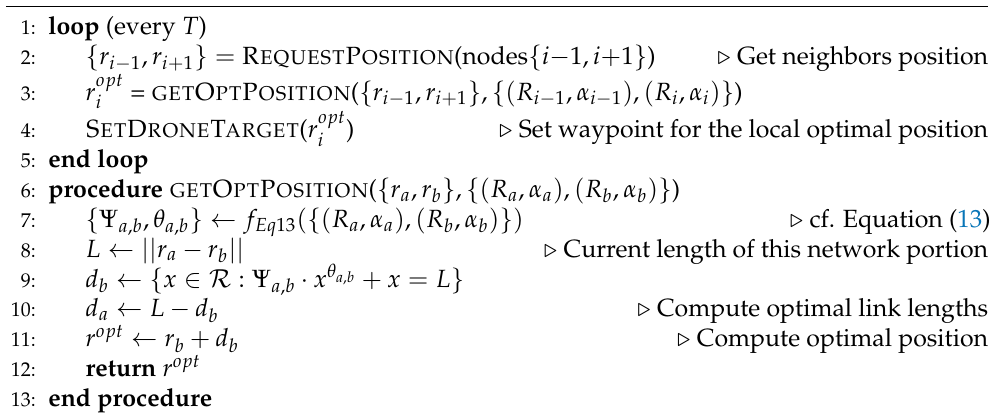
Algorithm 1 Pseudo-code for relay i in the distributed control